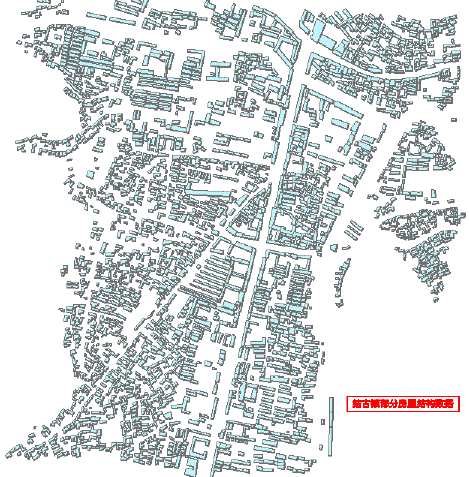
Figure 8: Building structures in Gyêgu town